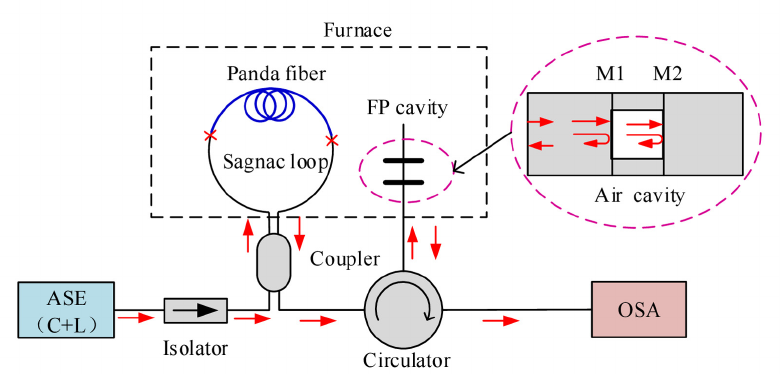
Figure 13. Vernier effect fiber sensor based on hybrid configuration (SI and FPI) [74]. Reprinted with permission from Ref. [74] ©The Optical Society.